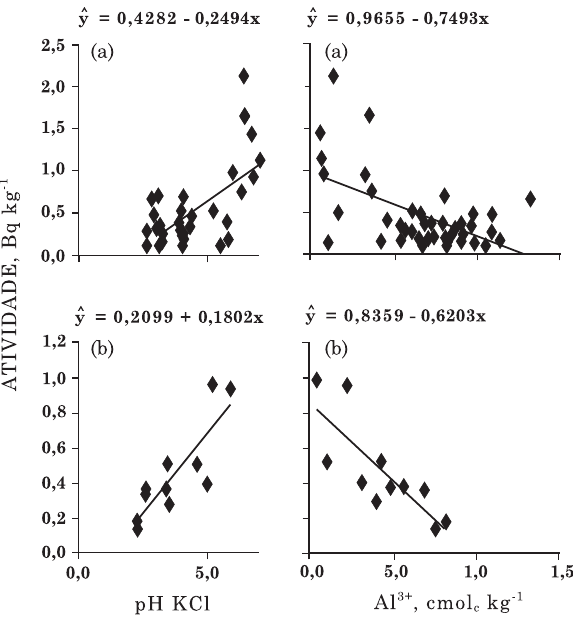
Figura 3. Correlações da atividade de 137 Cs com pH em KCL e com Al, nas três camadas superficiais (0 a 9 cm de profundidade) de três solos representativos de Pernambuco (a) e na camada de 3 a 6 cm de profundidade